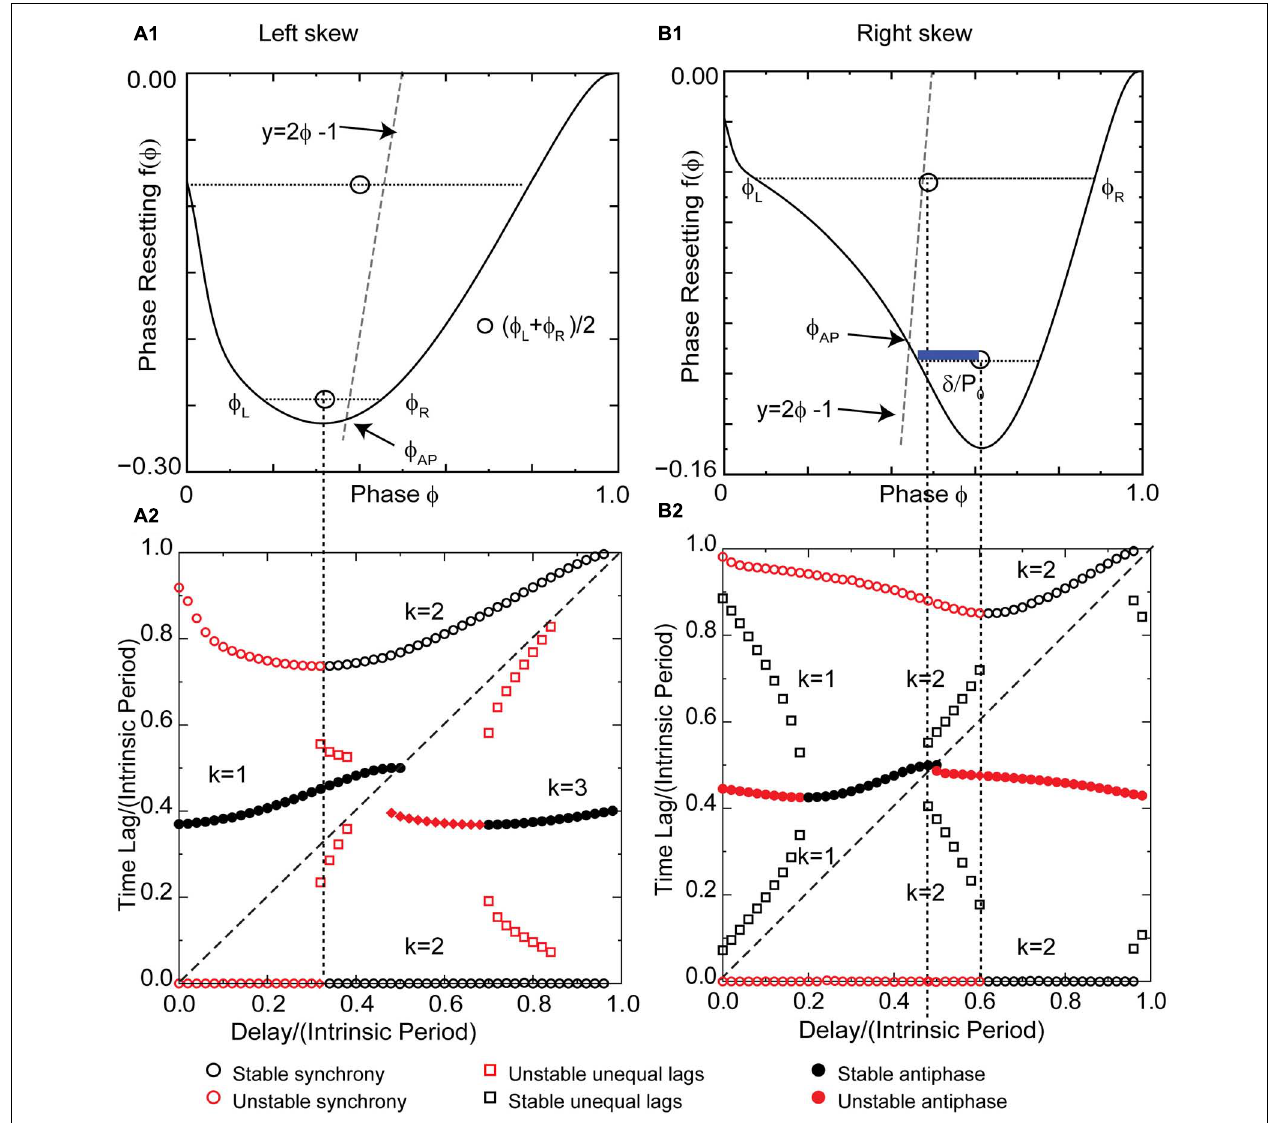
symbols (unstable mode), or a pair of black symbols (stable mode). Only one symbol is visible for antiphase because the two time lags are equal, indicated by a filled symbol. For synchrony one time lag is 0. (B1) Right skewed type 1 Wang–Buzsaki PRC with g K = 40 mS/cm 2 .The antiphase mode for zero delay falls on the unstable branch.The open circles that indicate the center between the two branches fall to the right of the dashed line, so there is an unequal time lag branch at short delays (black squares for k = 1 in B2 ).The blue bar shows a delay that falls on this branch. (B2) Predicted solution structure as delays are varied for two neurons coupled via the PRC in (B1) . k Values are given for the stable (black) branches.